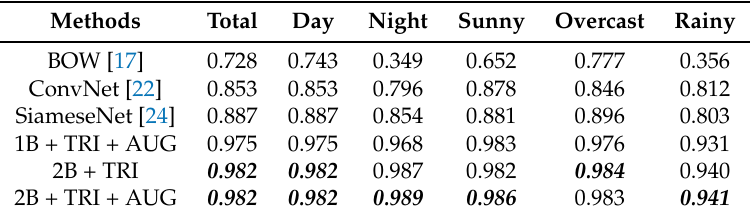
Table 4. Precision of compared methods in low traffic flow.